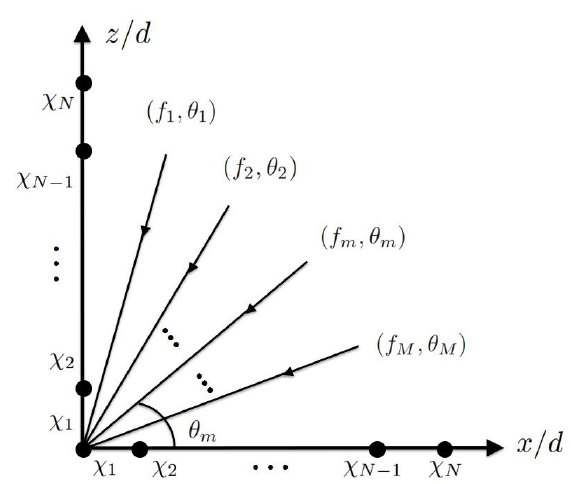
Figure 1. Orthogonal CPAs deployed along x and z axes, respectively, to estimate DOAs of M